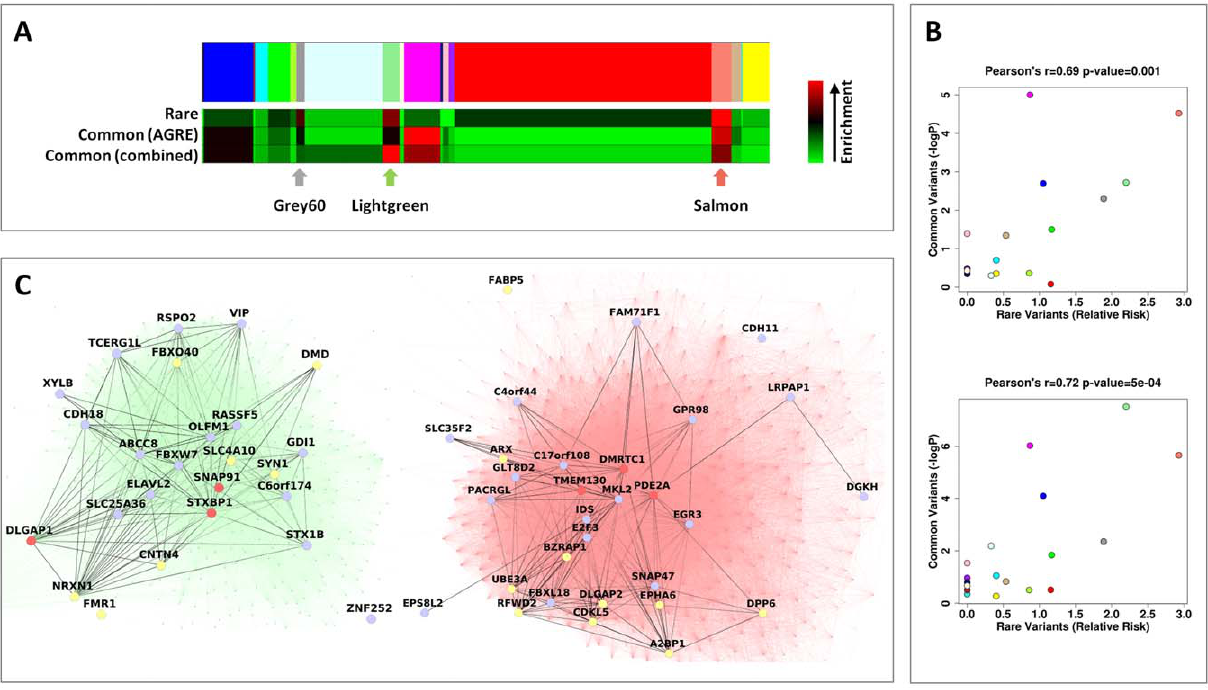
Figure 3. Rare and common variations in ASD perturb shared neuronal modules. (A) Color map showing the different modules in the WGCNA analysis. Below it, heat maps depicting, for each module, the relative risk (RR) for harboring genes with rare mutations (top), the enrichment for low GWAS p-values in the AGRE cohort (center) and the combined enrichment for low GWAS p-values across the three GWAS (bottom). The intensity of the red hue corresponds to higher enrichment of common or rare variants. (B) For each module, the enrichment for low GWAS P -values ( 2 log 10 P ) in the AGRE cohort (top) or combined across the three cohorts (bottom) is plotted against the relative risk for rare mutations. The color of the points corresponds to the names of the modules. (C) The connections in the two neuronal modules enriched for common and rare variations, Lightgreen (left) and Salmon (right), are visualized. Three highly connected genes in each module (hub genes) are shown in red; genes with a gene- wide p-value , 0.05 in light blue, and genes with known rare mutations in autism in